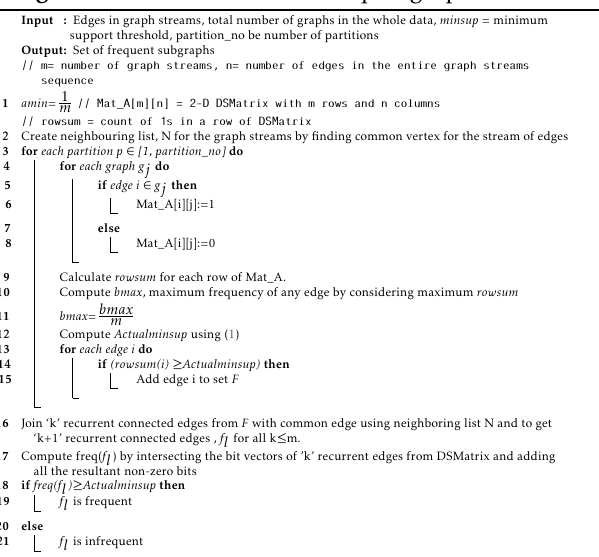
Algorithm 3: PartitionStaticFreqSubgraph